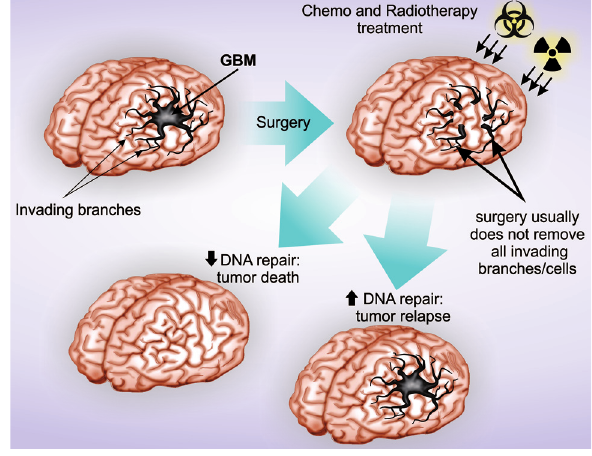
Figure 2 - DNA repair competences predispose GBM to treatment resis- tance. The current standard treatment for GBM consists of surgery fol- lowed by chemoradiotherapy. Surgery frequently presents low efficiency due to the invasive nature of GBM cells, making difficult the complete re- section. Tumors cells with higher DNA repair capabilities can efficiently manage chemoradiotherapy-induced DNA damage and support subse- quent tumor relapse. Successful treatment is attainable when surgery can safely remove at least 75% of tumor tissue and the remaining cells present low DNA repair